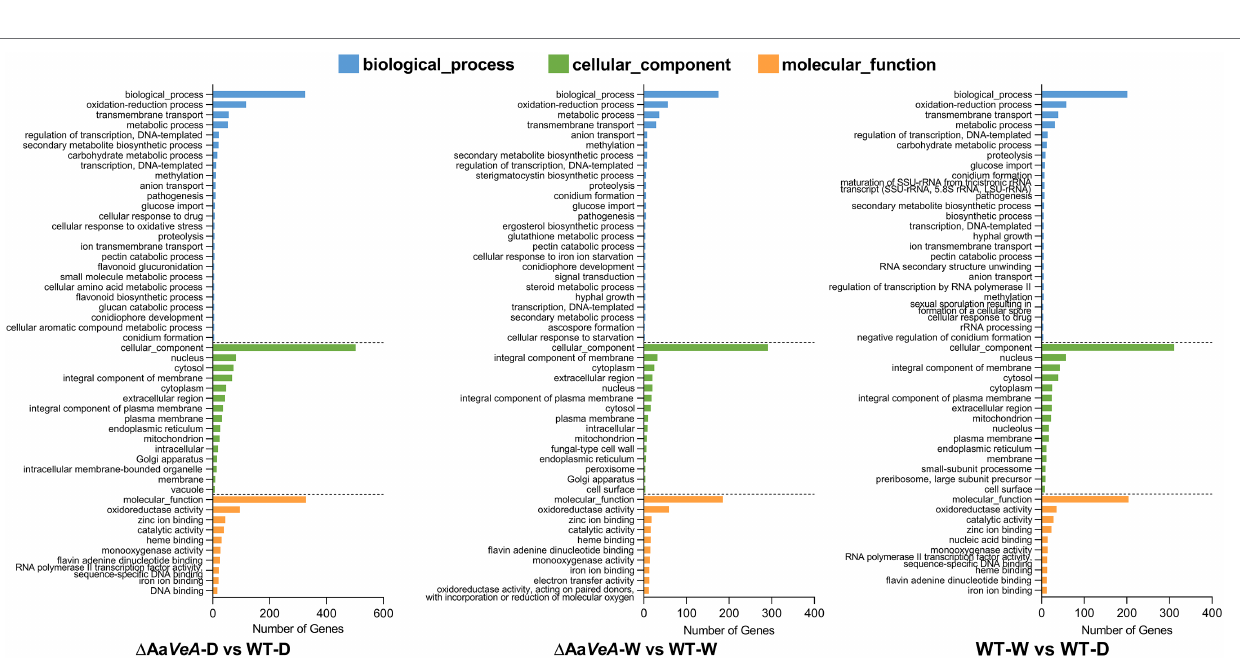
FIGURE 4 | Gene Ontology (GO) enrichment analysis of differentially expressed genes (DEGs). The comparative DEGs were employed to carry out GO analysis in both groups